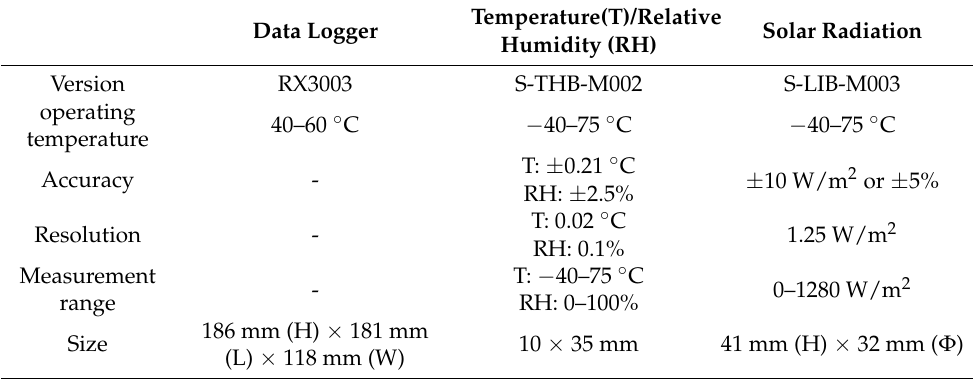
Table 1. The basic information of sensor set used in this